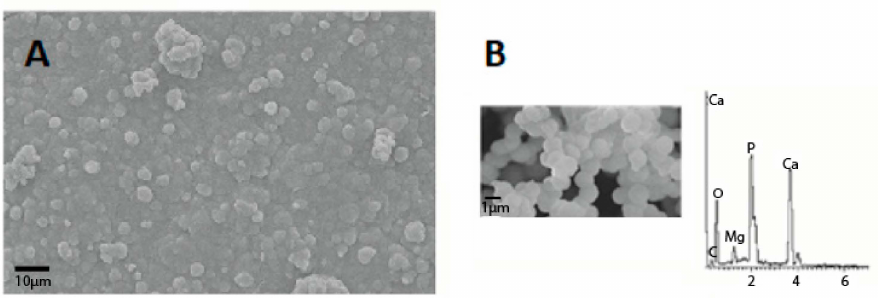
Figure 10. SEM micrographs of the geopolymer–Portland cement composite soaked in simulated body fluid for 28 days with globular hydroxyapatite crystals formed on the surface ( A ); EDS analysis of hydroxyapatite formed on geopolymer surfaces after soaking in SBF ( B ) [104].